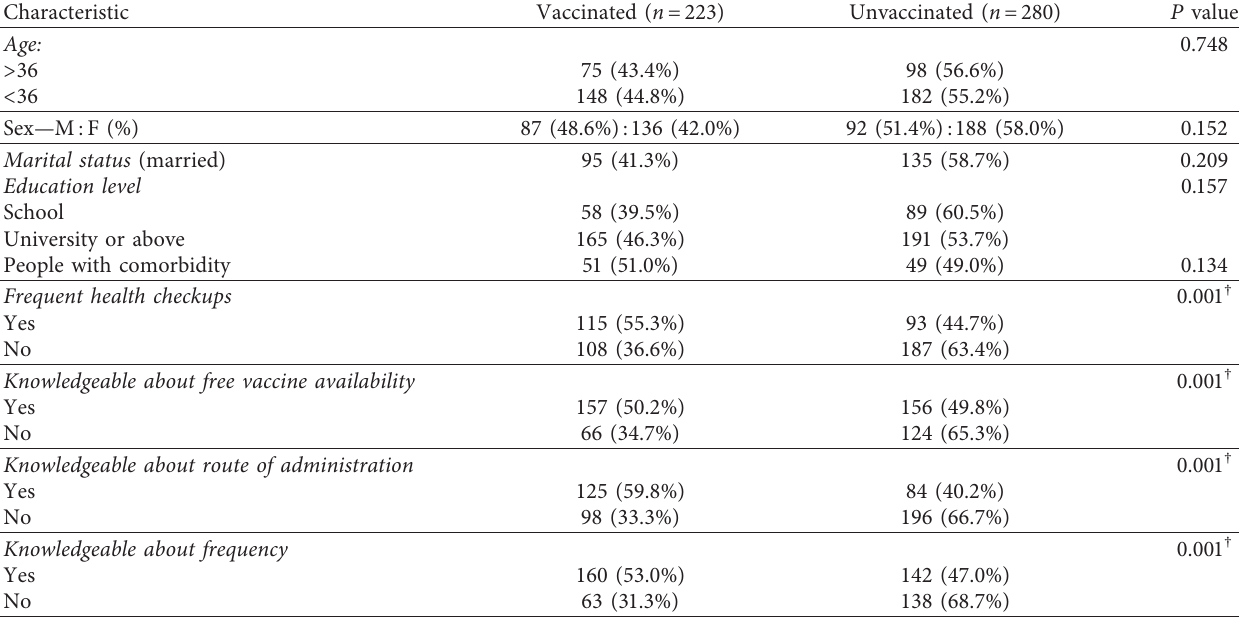
Table 3: Participant’s characteristics’ association with influenza vaccine